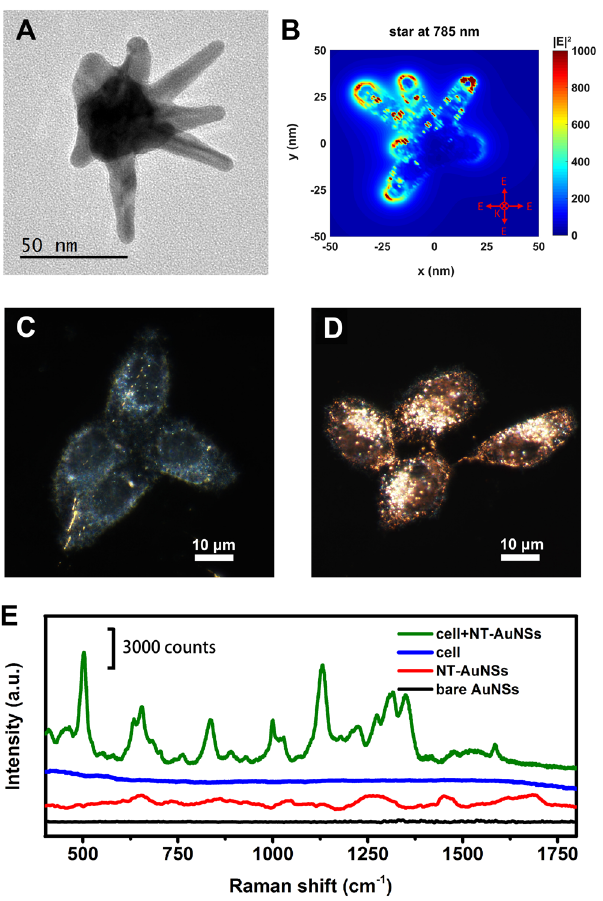
Figure 1. ( A ) Transmission electron microscopic (TEM) micrograph of AuNS. ( B ) Finite-Difference Time- Domain (FDTD) simulated distribution of localized electronic field of AuNS at Raman incident wavelength. Dark field images of MCF-7 cells pre-incubated without ( C ) and with ( D ) 0.05 nM NT-AuNSs for 24 h. ( E ) Typical Raman spectra of cells with and without NT-AuNSs, and the spectra of NT-AuNSs, and bare